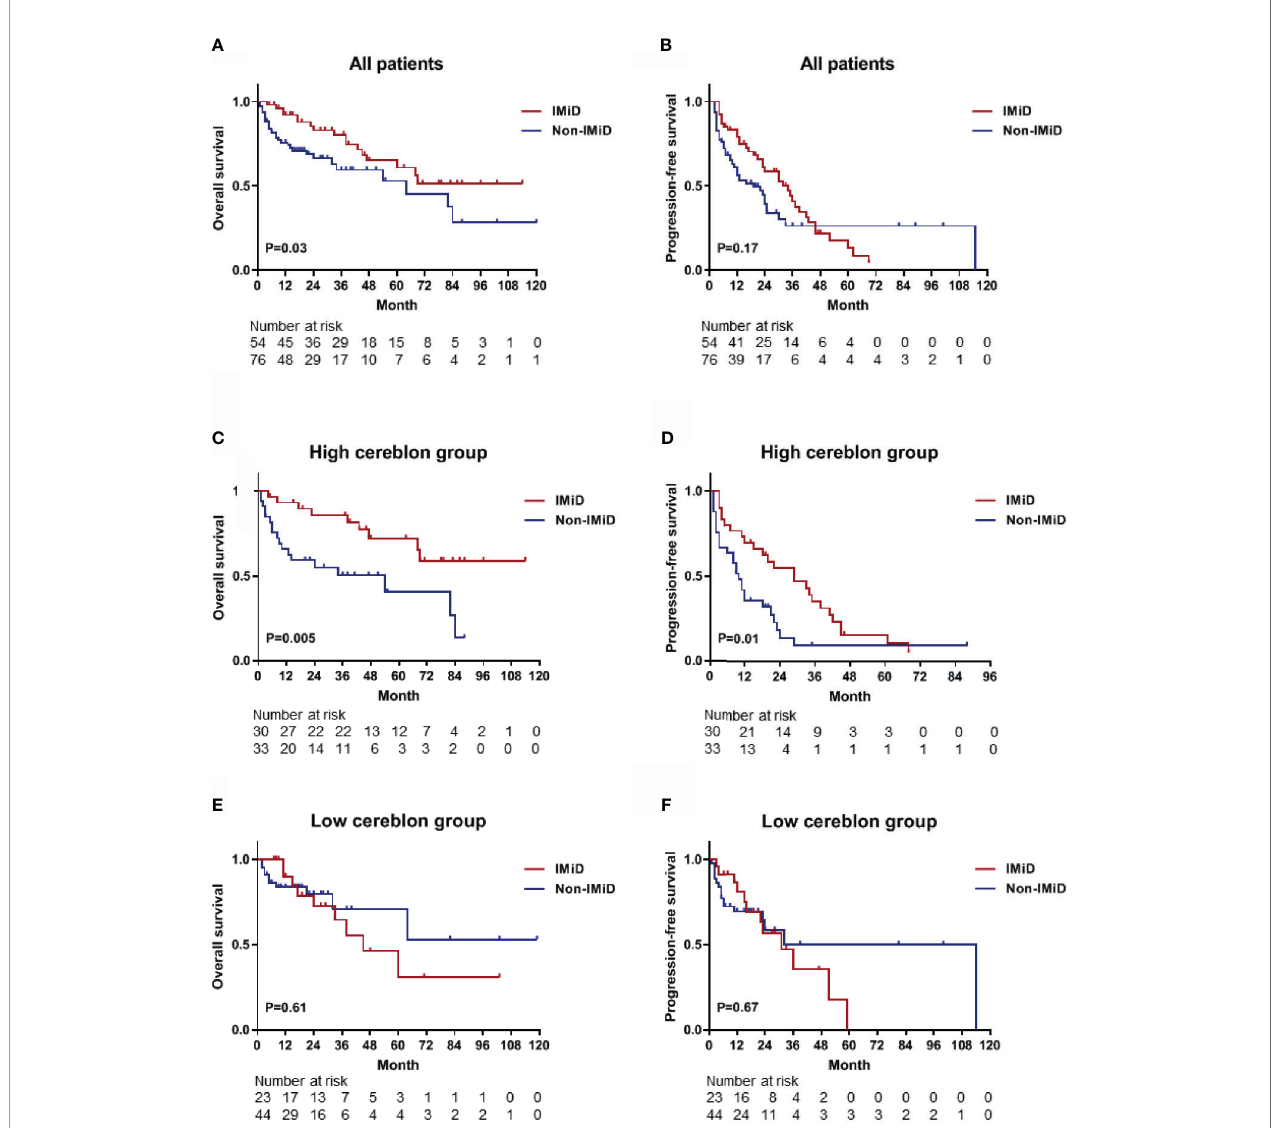
FIGURE 4 | Kaplan – Meier survival curves for OS and PFS. (A, B) The OS and PFS curves for all patients (n = 130) who received any type of drug therapy. The median OS and PFS were NR (not reached) and 34 months in the IMiD group and 64 and 19 months in the non-IMiD group, respectively. (C, D) The OS and PFS curves for the high CRBN group (n = 63). The median OS (NR vs . 54 months) and PFS (29 vs . 10 months) were signi fi cantly longer in the IMiD group compared to the non-IMiD group. (E, F) The OS and PFS curves for the low CRBN group (n = 67). The median OS and PFS of the IMiD and non-IMiD groups were 45 months and NR for OS and 31 and 32 months for PFS, respectively. IMiD, immunomodulatory drug; OS, overall survival; PFS, progression-free